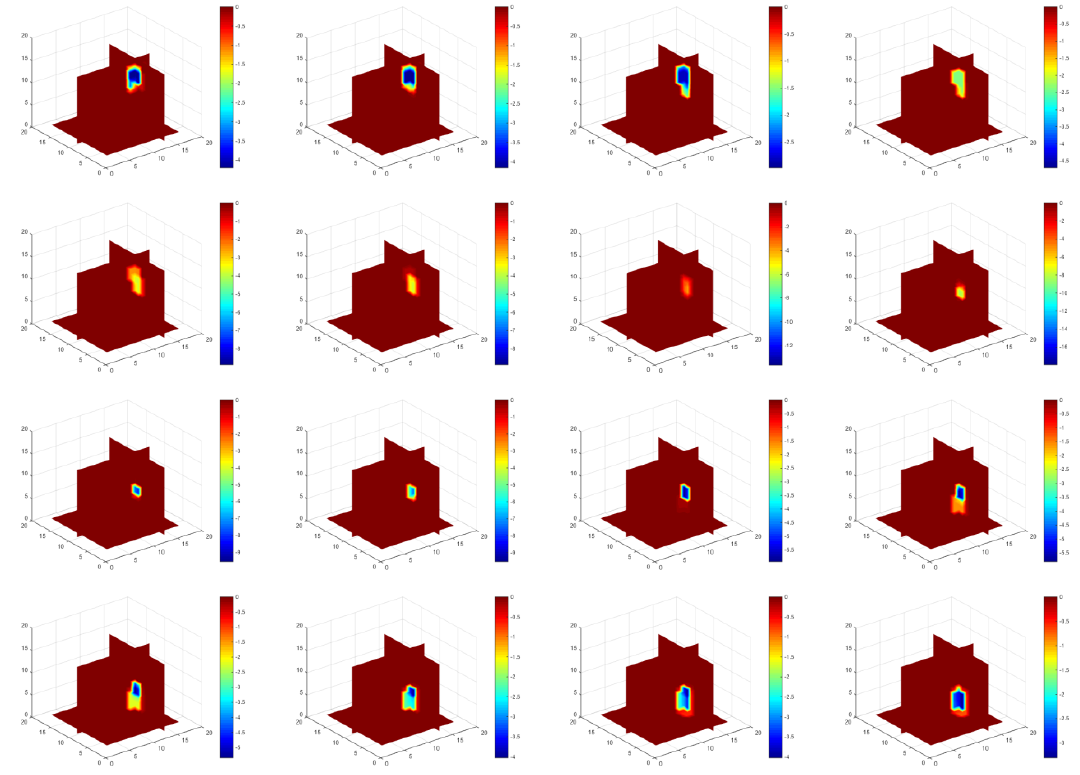
Figure 10. Image reconstruction of 3D simulation using temporal TV: images displayed here are illustrates movement from the top to bottom, which is consistent with the set up of 3D simulation test.